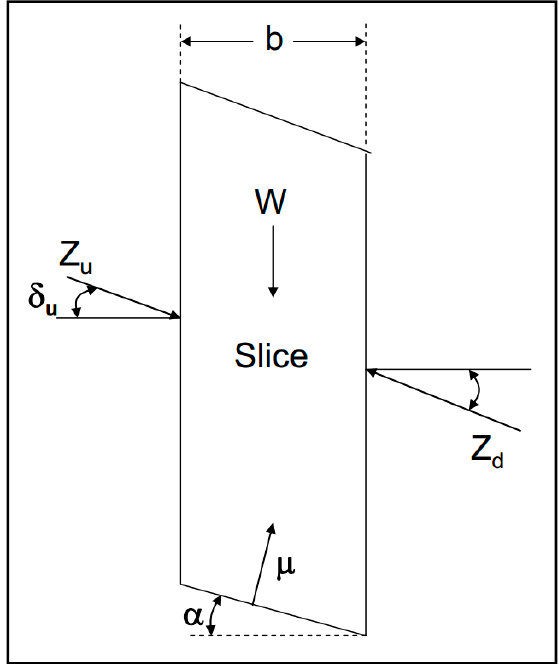
Figure 7. Spencer Method of Internal Stability Analysis.